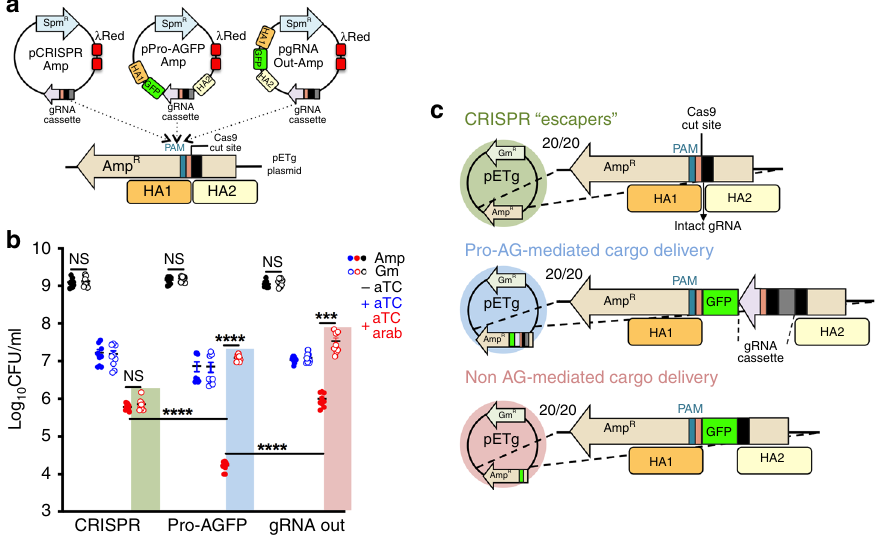
Fig. 3 The Pro-AG system mediates ef fi cient editing and cargo delivery dependent on precise fl anking of the gRNA cassette by homology arms of the target gene. a Schematic of plasmids used to compare performance of CRISPR-control (pCRISPR Amp), Pro-AGFP (pPro-AGFPAmp: gRNA2 + GFP within homology arms), and external placement of gRNA2 outside of the homology arms fl anked cassette (pgRNA Out-Amp: GFP-only within homology arms, gRNA outside of HA-cassette). b Recovery of E. coli CFU following CRISPR-control or Pro-AG using the three different plasmid con fi gurations indicated in a and the various induction conditions indicated in the key. c Sequence analysis of targeted plasmids. pETg plasmids recovered from CRISPR-control-treated colonies (green circle) all display intact target sequence ( “ escapers ” ). Analysis of all Pro-AGFP-recovered pETg plasmids (blue circle) con fi rmed precise insertion of the gRNA + GFP cassette at the gRNA cut site, which consists of the full gRNA cassette (scaffold, purple; gRNA, pink and black, and tet promoter, gray) plus GFP. Although the gRNAOut-targeted pETg con fi guration (red circle) resulted in ~ 100-fold less ef fi cient targeting of the bla target gene than the Pro-AGFP con fi guration, all plasmids isolated from colonies selected on Gm plates carried precise insertions of the GFP-only cassette. Data in b are plotted as the mean ± SEM, representing three independent experiments performed in triplicate and analyzed by Student ’ s t test. N.S . = not signi fi cant ( P > 0.05); *** P < 0.001; **** P < 0.0001. Source Data are available in the Source Data fi